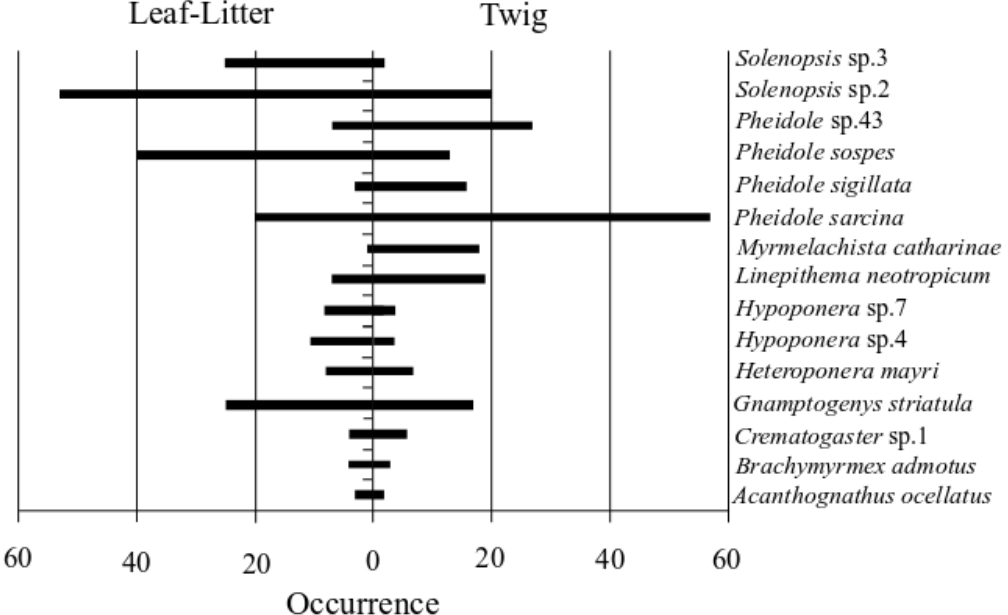
Fig 2. Total number of ant species colonizing both leaf litter and twigs.